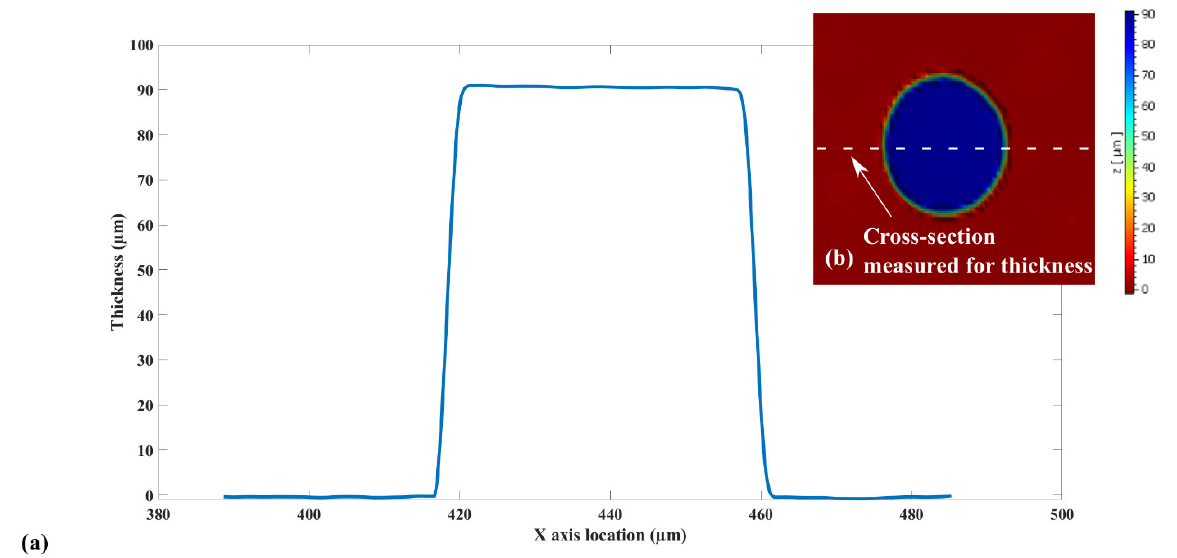
Figure 12. SU-8 mass load white-light interferometer measurement result. ( a ) The thickness measurement. ( b ) The SU-8 pillar measured.